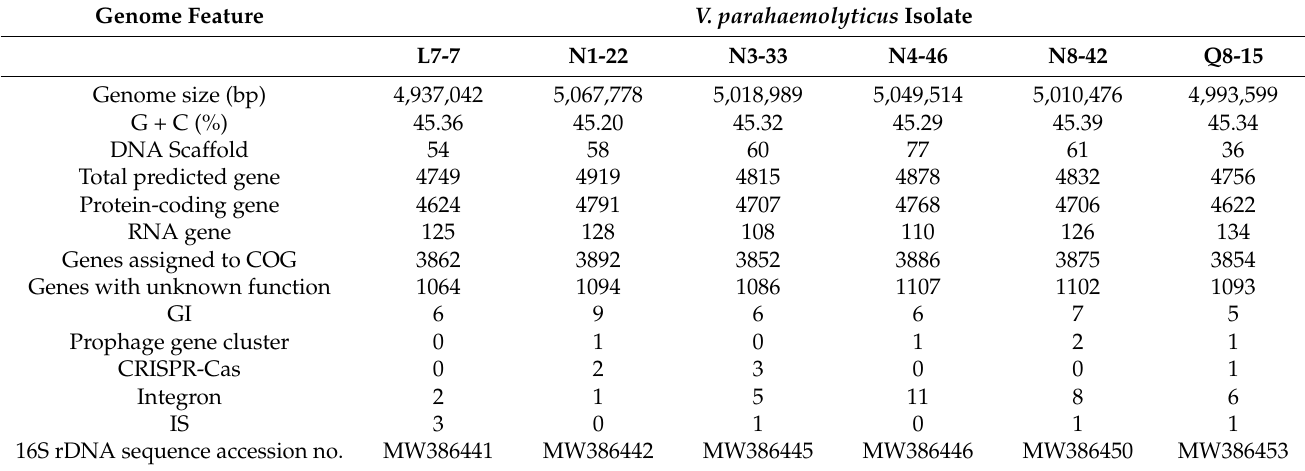
Table 1. Genome features of the six V. parahaemolyticus isolates originating in edible aquatic